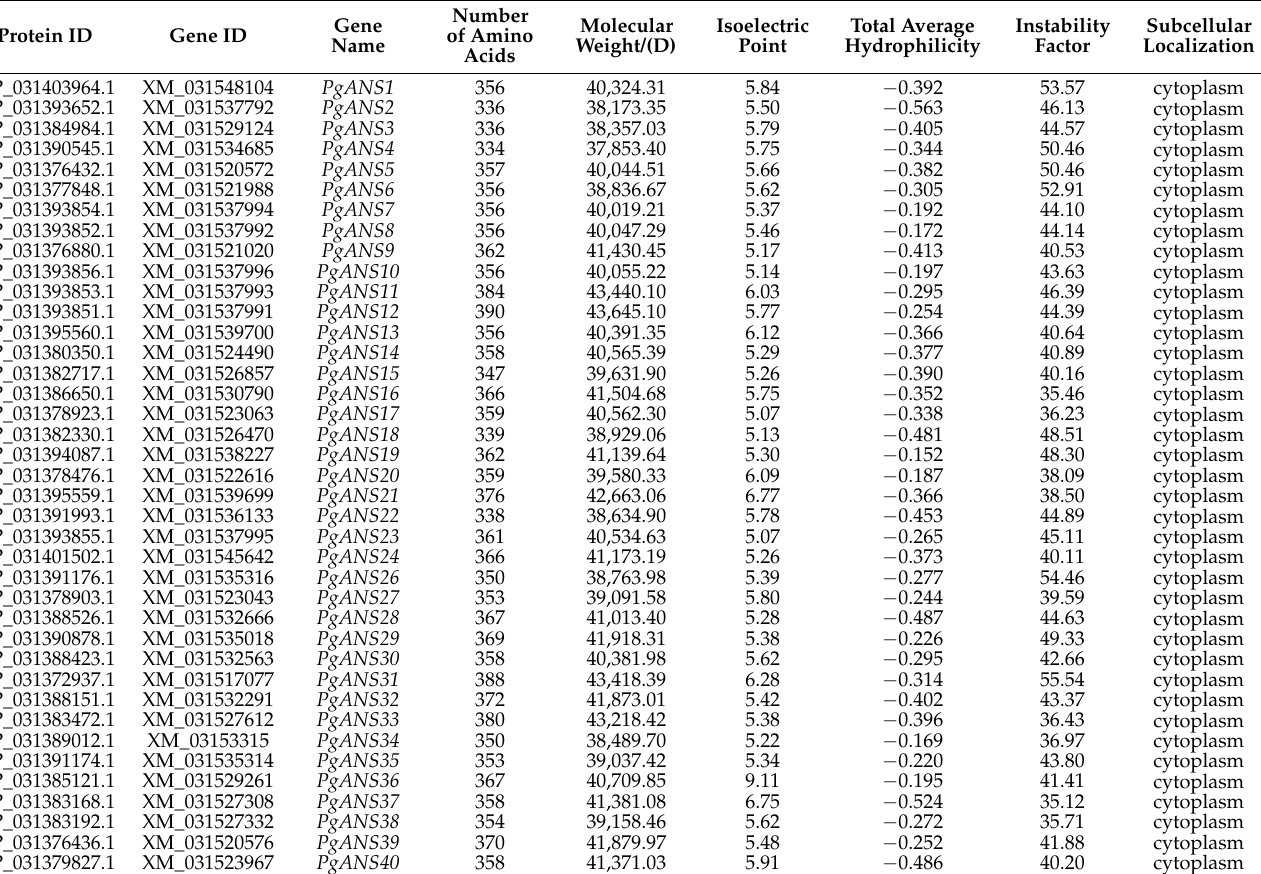
Table 1. Information on the members of the pomegranate ANS gene family